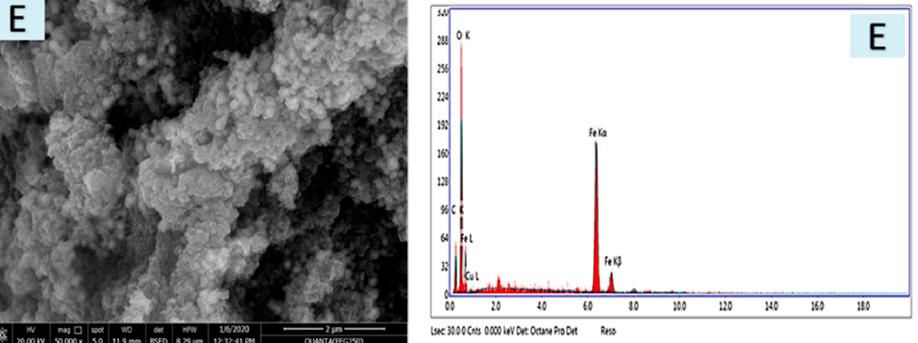
Figure 3. SEM and EDX of ( A ) Cellulose, ( B ) Acell), ( C ) nNiO/Acell, ( D ) nCuO/Acell and ( E )